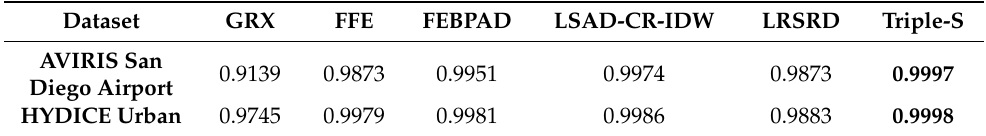
Table 1. AUC scores of different methods.